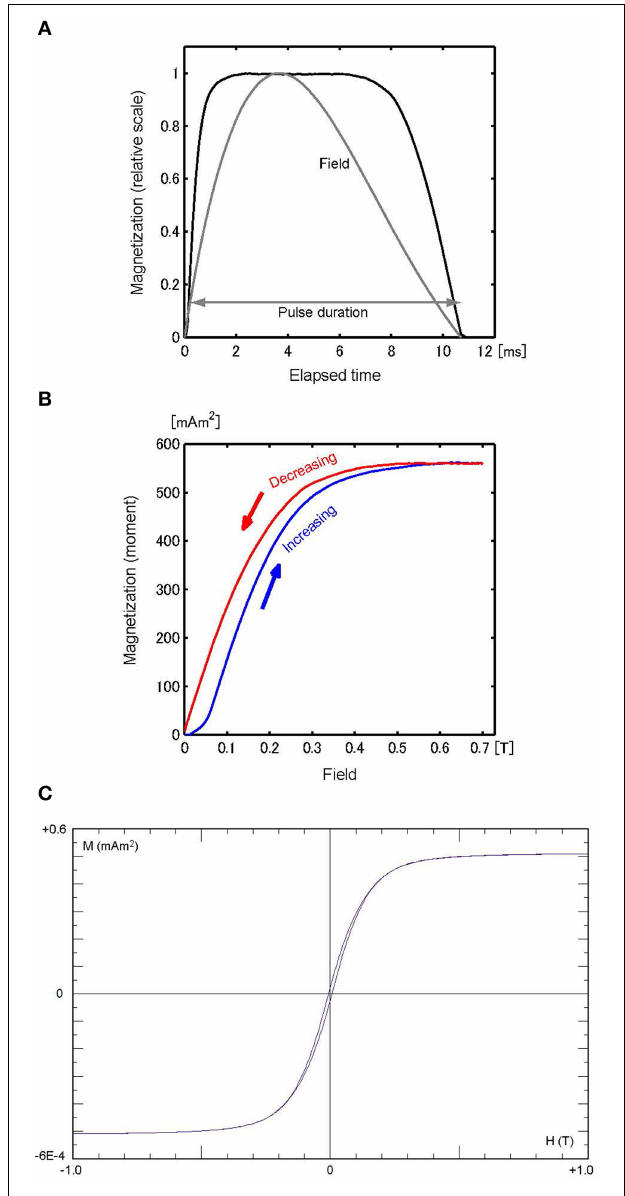
FIGURE 3 | (A) M-t curve of sample Ni, scaled to the maximum magnetization (561mAm 2 ), with the H–t curve (gray) scaled to 0.7 T. (B) M–H curve for the increasing field (blue) and reducing field (red). (C) Hysteresis loop of Ni (10.7mg).